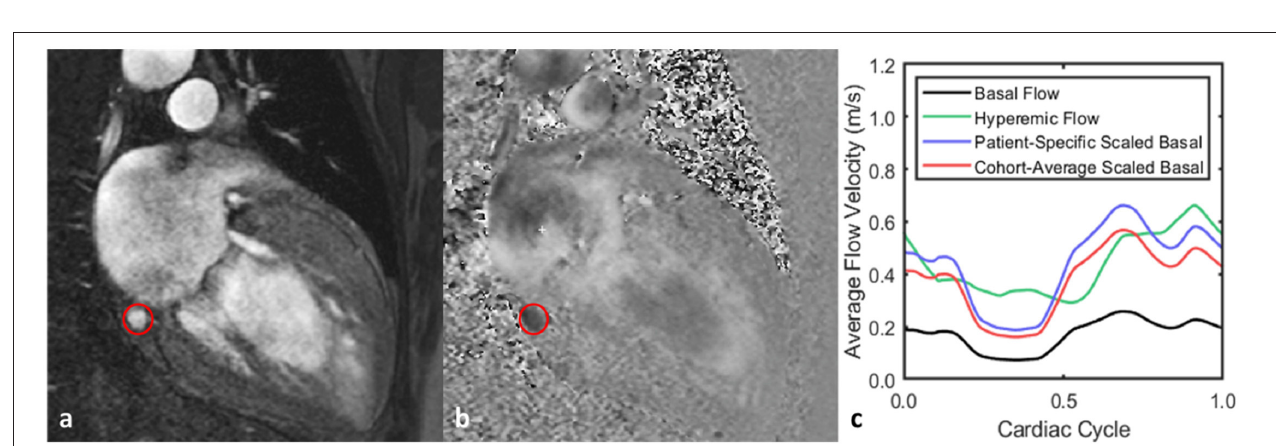
FIGURE 3 | Generation of coronary arterial geometry from MRA data. The left main (LM), left anterior descending (LAD), and left circumflex (LCX) arteries were segmented from a 3D MRA dataset data using the Vascular Modeling Toolkit (VMTK) (left) . The resulting surface geometry was imported into Geomagic to generate a smooth 3D surface (center) . This surface was imported into ICEM meshing software to generate the 3D computational mesh, and transient CFD simulations were run using Fluent (right) . Flow boundary conditions were based on PCMR measured flows.